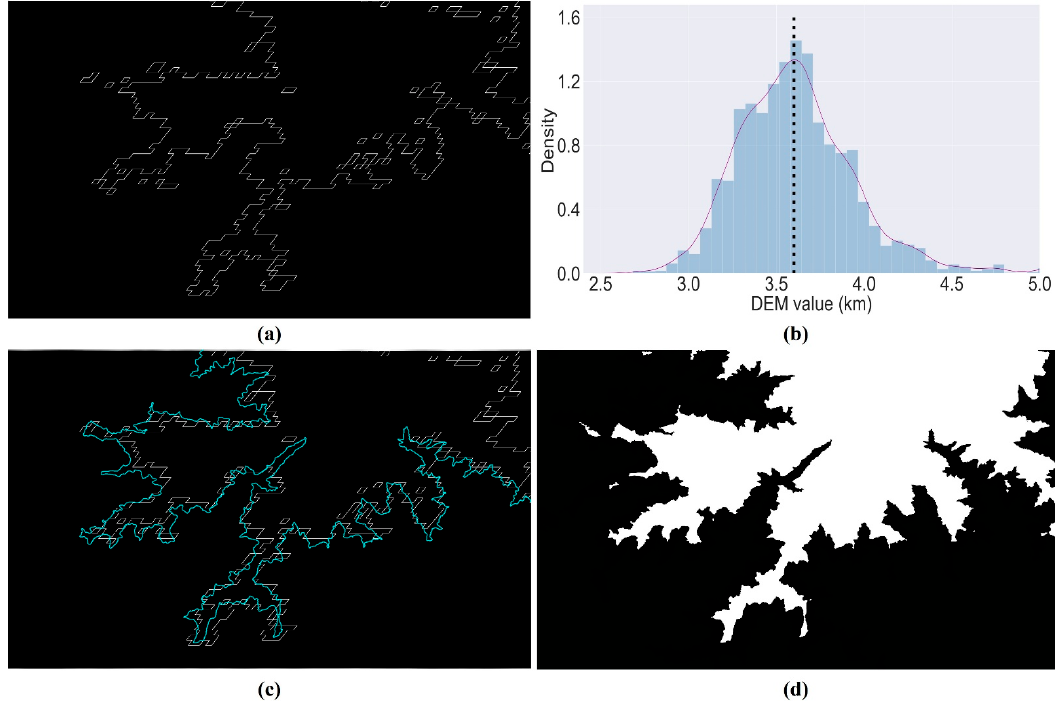
Figure 6. The process of making snow masks using DEM. ( a ) is the snow cover boundary extracted using MODIS NDSI. ( b ) is the frequency histogram of the DEM data located at the extracted snow cover boundary from MODIS NDSI. ( c ) The bright line is the extracted boundary overlaid on the DEM height of 3600 m. ( d ) is the snow mask extracted from DEM. The white part is snow, and the black part is non-snow.